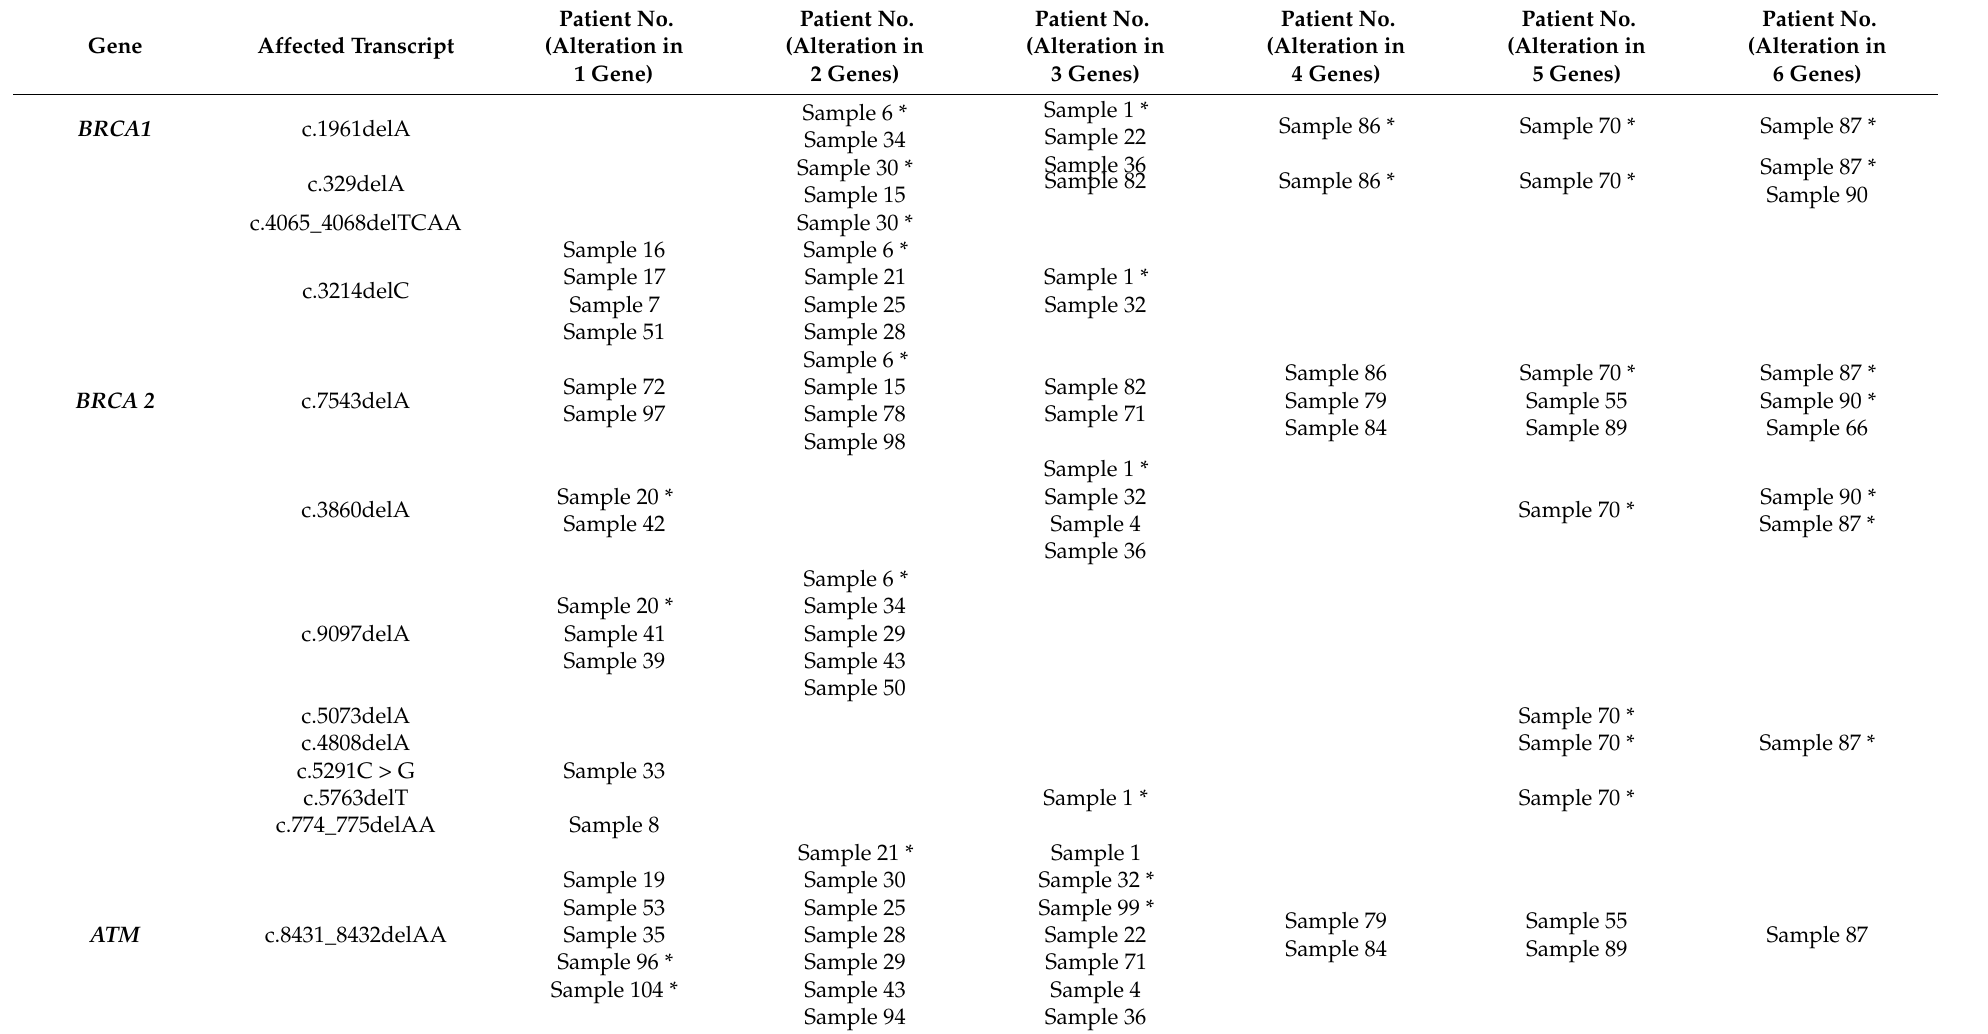
Table 4. List of patient numbers that carried pathogenic germline mutations in single and multiple genes.